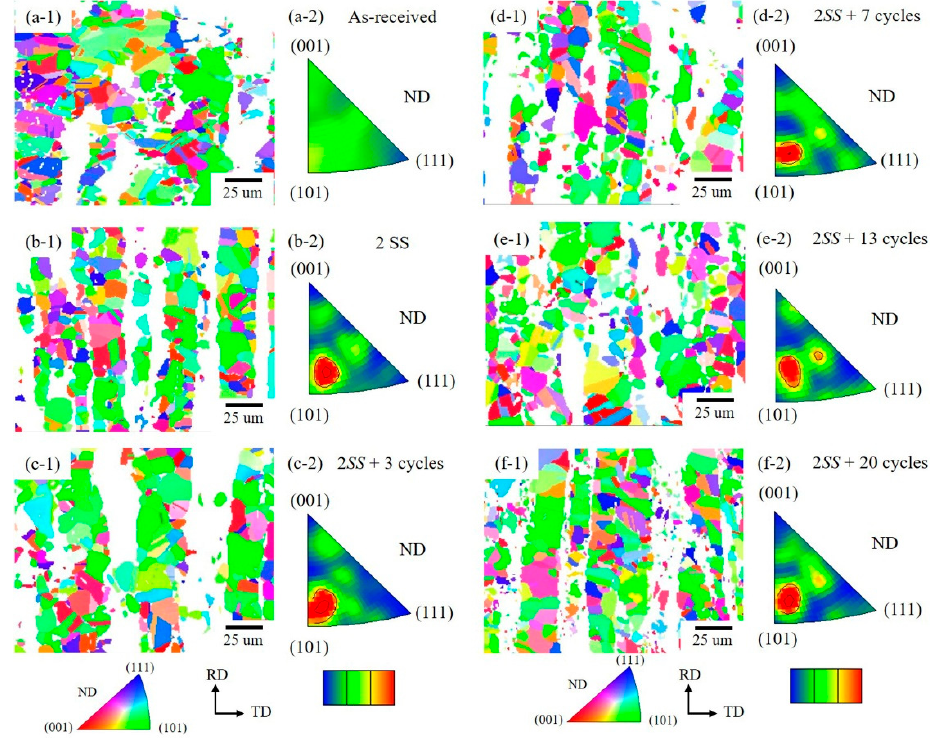
Figure 9. The grain most frequent orientation of γ was relatively stable at < 315 > orientation close to < 101 > under di ff erent thermal cycles from ( b ) to ( f ), except the random distribution for